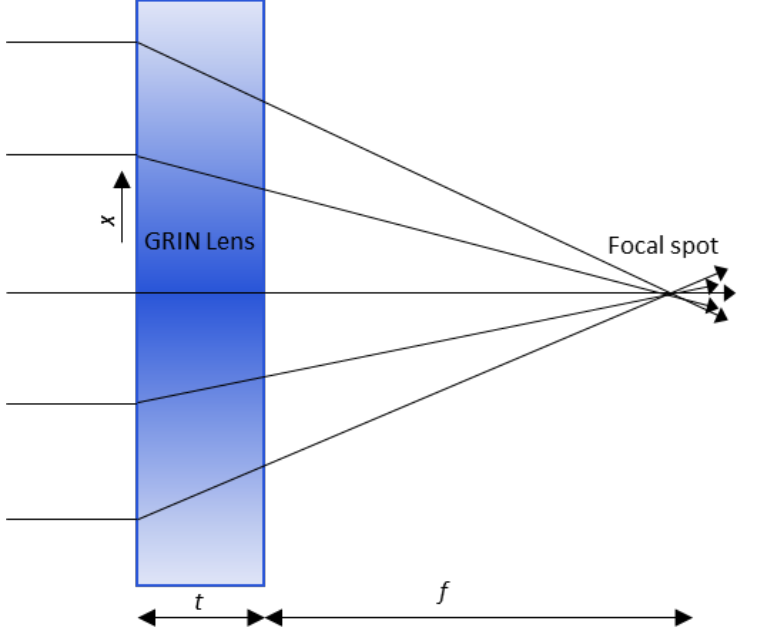
Figure 1. GRIN Lens operation. Shading of the lens indicates the gradient in the index: darker shading corresponds to a higher refractive index value.